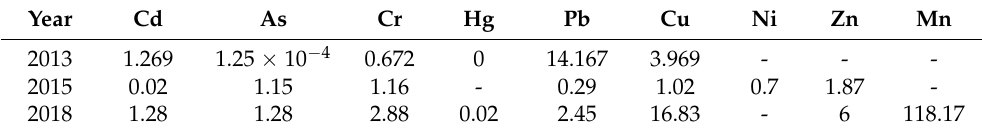
Figure 1. Schematic map of the Liujiang Basin and the sampling sites. Table 1. Liuzhou annual average concentration of heavy metal pollutant statistics ( µ